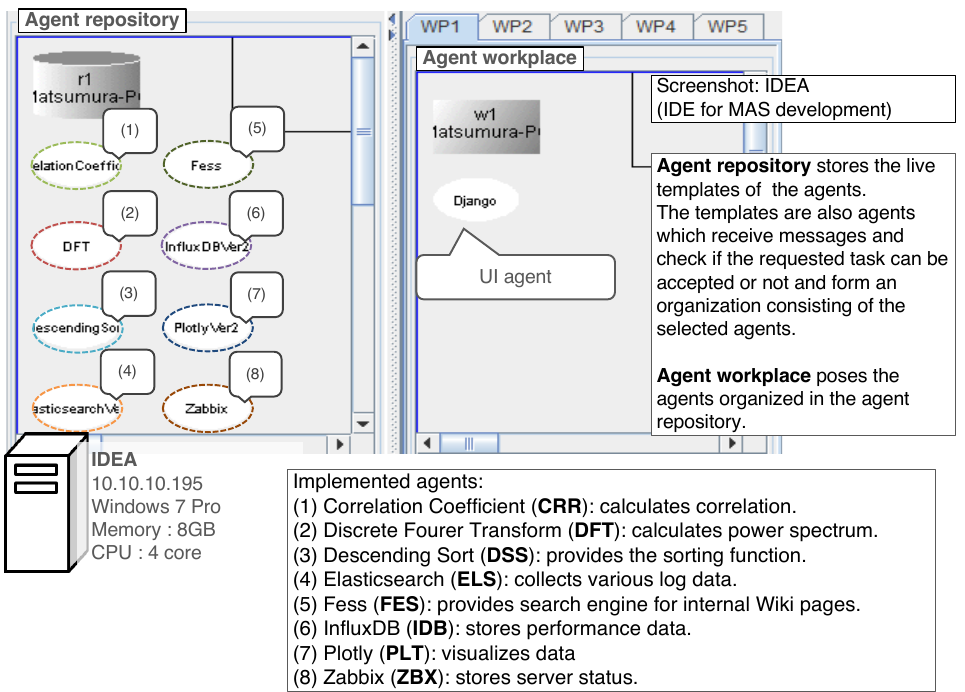
Figure 9. Screenshot of the initial state of the prototype system with descriptions. We implemented eight DPAs and a user interface (UI) agent. The MADPM works among the